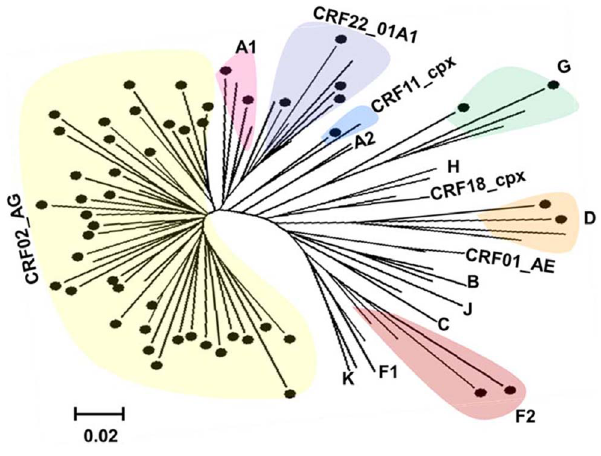
Figure 1. Phylogenetic analysis of the HIV-1 partial env region genome sequence. Analysis was performed using the neighbor- joining methods in Mega 5 program. Thereference subtypes and CRFs were used to construct the tree, and some references have been omitted for clarity. Bootstrap value above was 70%. The scale bar N represents 2% genetic distance. The identified HIV-1 strains are ’’. indicated as full black circle ‘‘